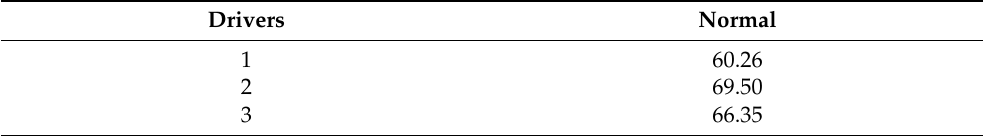
Table 8. Driver’s heart rate